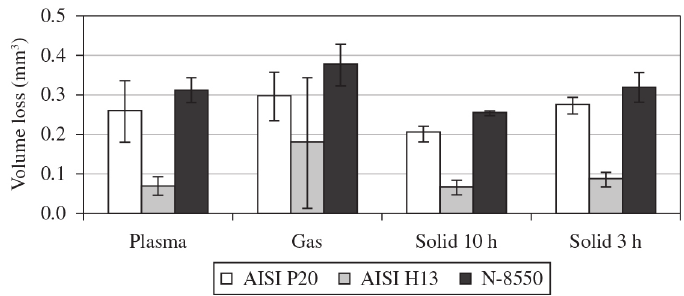
Figure 8. Wear volume results for the steels AISI P20, AISI H13 and N-8550 according to the thermochemical treatment conducted.